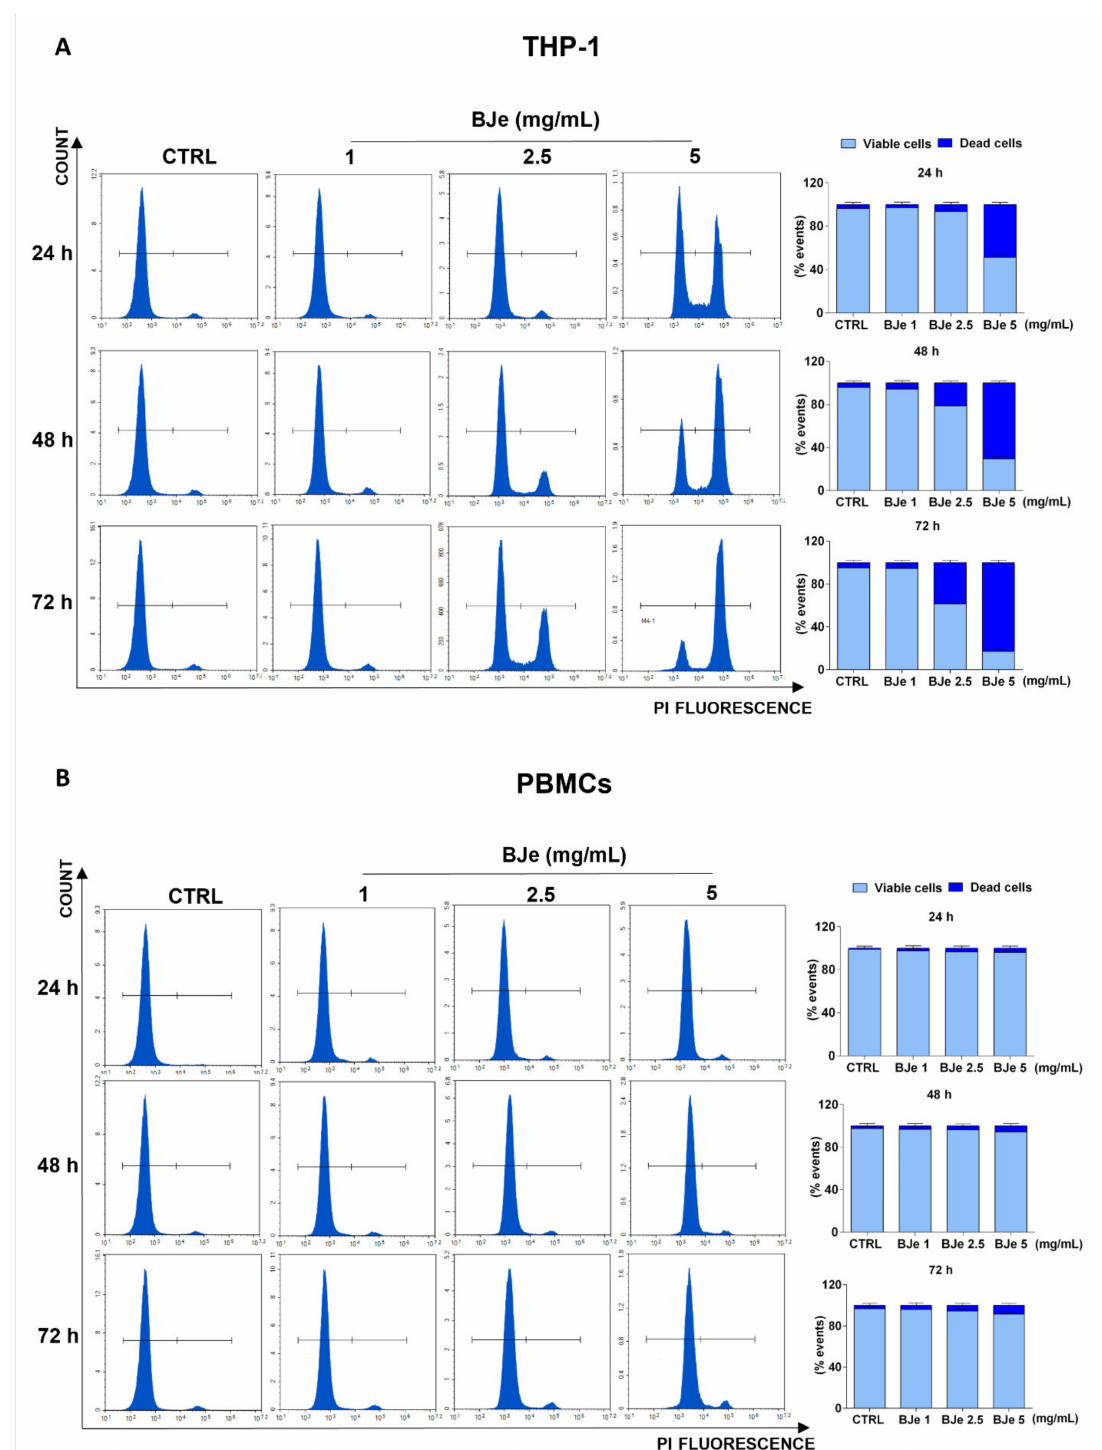
Figure 3. Cytotoxicity evaluation of BJe in THP-1 cells and PBMCs. Both cell lines were exposed to different concentrations of BJe (1–5 mg/mL) for 24, 48 and 72 h. Cytotoxic activity of BJe was evaluated by PI staining through flow cytometry ( A , B ). On the left, representative plots of three different experimental sessions of PI staining performed in triplicate ( n = 9) are displayed, where the first peak represents viable cells, while the second one dead cells. On the right, histograms report the percentage of viable (PI − ) and dead (PI + ) cells ± SEM of three independent experiments performed in triplicate ( n =